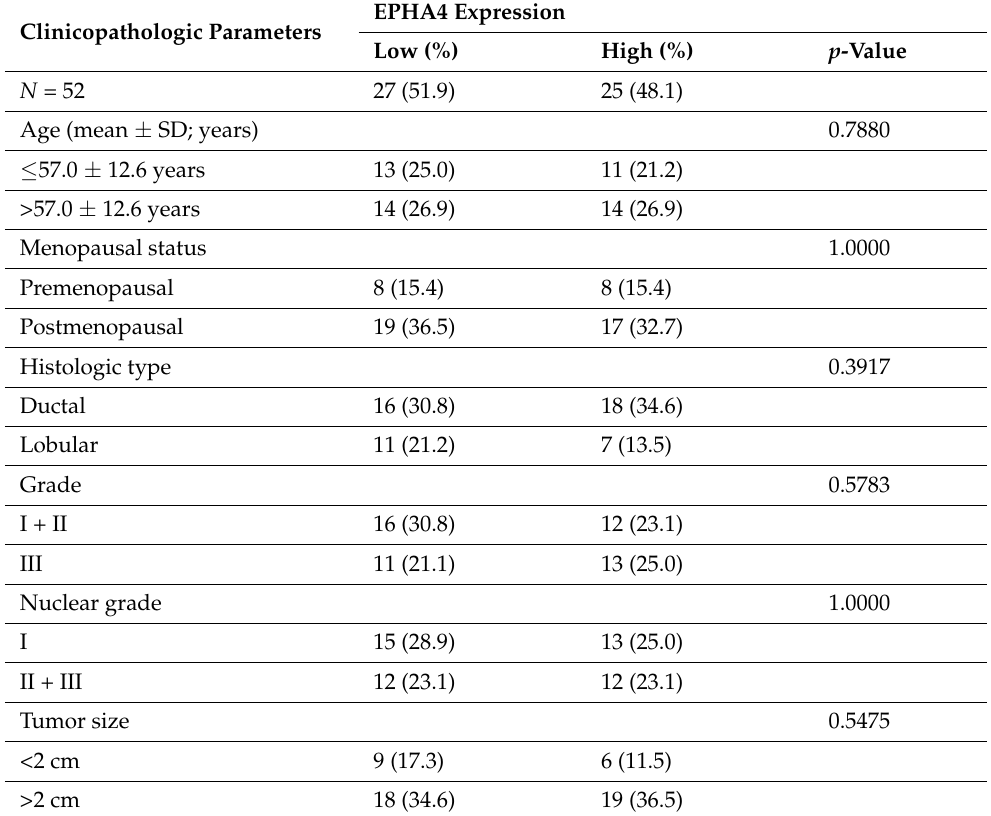
Table 2. Association of EPHA4 expression with selected clinicopathologic parameters in 52 triple- negative breast cancer (TNBC) patients ( p -values calculated through the Fisher’s exact